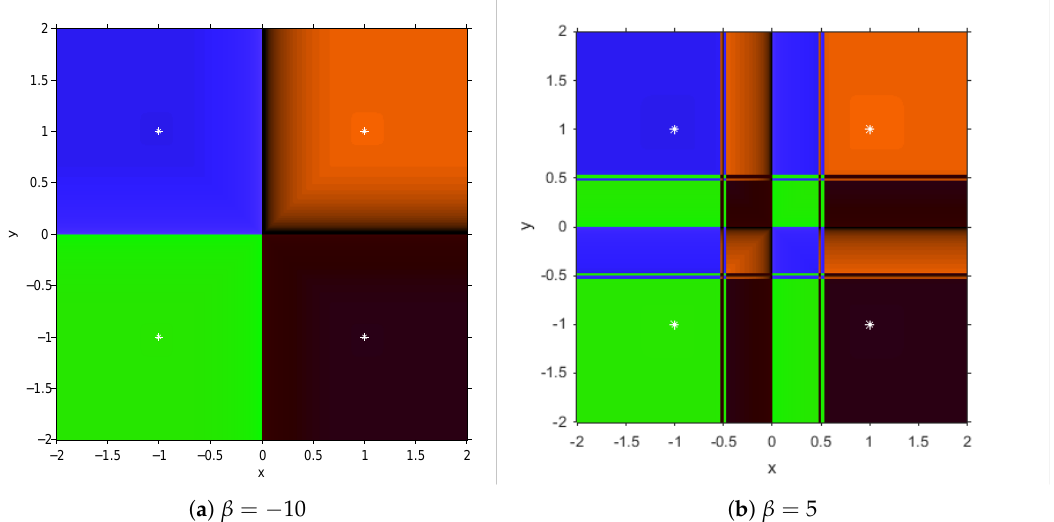
Figure 8. Dynamical planes for stable values of β of class M42 on p ( x ) .